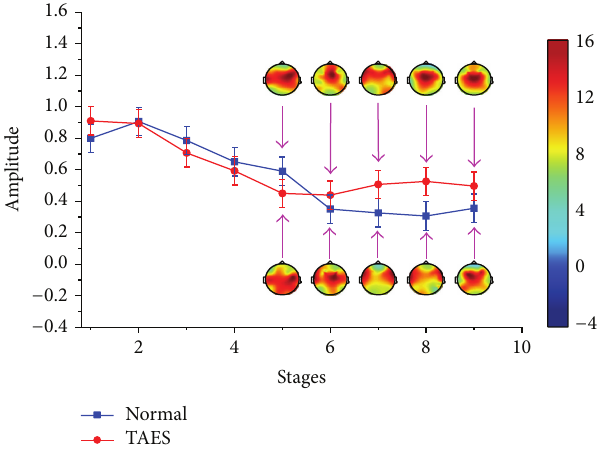
Figure 6: Relative power spectrum (mean ± S.D.) of 𝛽 subband for 9 stages of